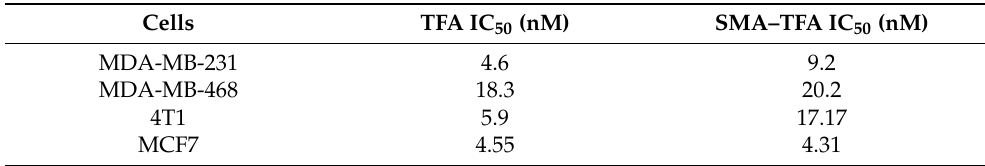
Table 2. Experimental IC 50 values (nM) of free TFA and SMA–TFA towards human MDA-MB-231,